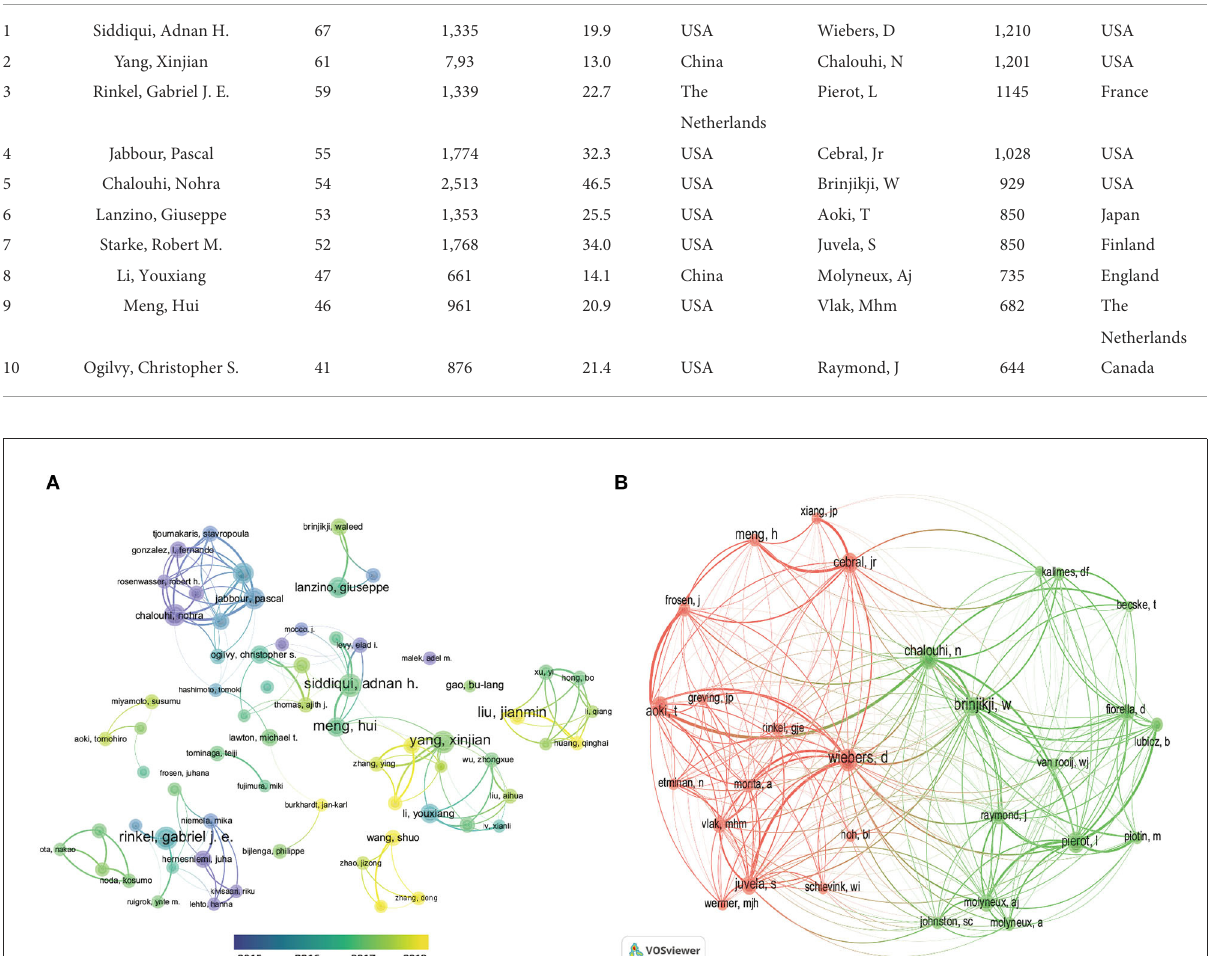
FIGURE5 Author cooperation network and co-cited author network on IA studies from 2012 to 2021. (A) Collaborative map of prolific authors for IA studies from 2012 to 2021. (B) Co-cited authors of IA studies. Node size indicates the number of articles produced. The distance between any two nodes positively associates with the cooperation